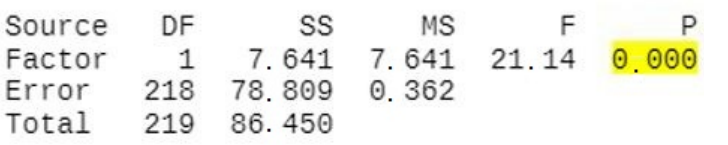
10 of 18 Figure 8. The Box plot shows the five-number summary of our set of data: including the minimum score, first (lower) quartile, median, third (upper) quartile, and maximum score. The box for B1 is actually a line (quarta Q1 and Q3 = 2 overlap). There are significant differences.The median is the red line through the middle of the ‘box’. We can see that this is just above the number 60 on the number line below. So the middle value of age is 60 years. The upper side of the box is the 1st quartile. This is the value that separates the first quarter, or 25% of the data, from the rest. The lower side of the box is the 3rd quartile. This is the value that separates the first three quarters, or 75% of the data, from the rest. The distance between the sides of the box is called the inter-quartile range (IQR). This tells us where the ‘middle half’ of the values are. The ends of the lines from the box at the left and the right are the minimum and maximum values in the data. The distance be-